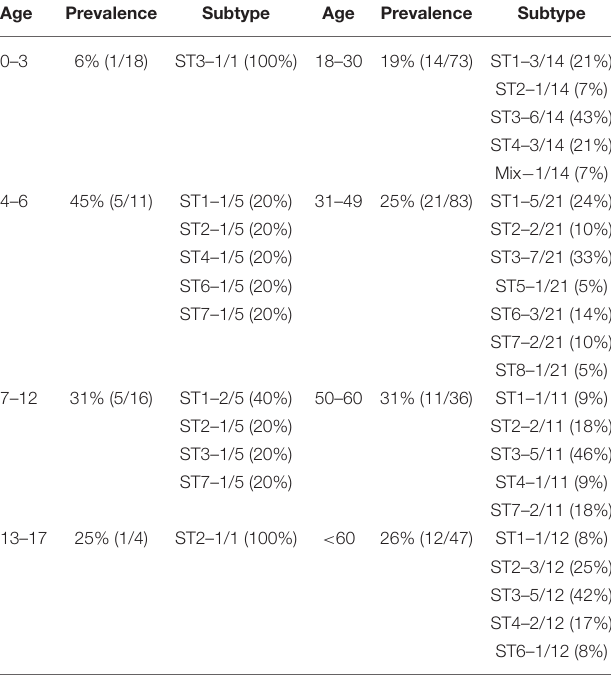
TABLE 2 | Prevalence and incidence of Blastocystis sp. subtypes in humans based on the age groups.